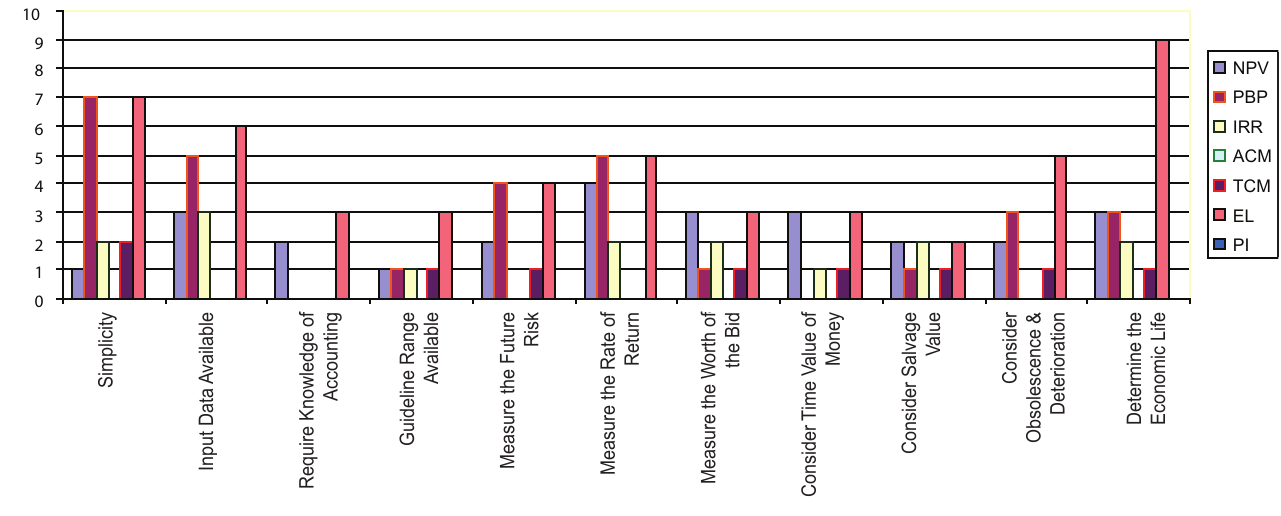
Figure 1: Effectiveness of financial evaluation